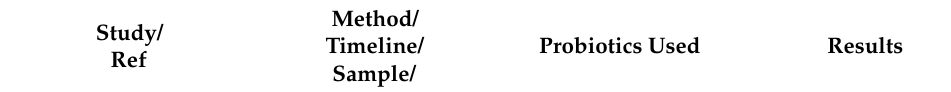
Table 2. Probiotics administration to diabetes mellitus patients undergoing bariatric surgery (clinical